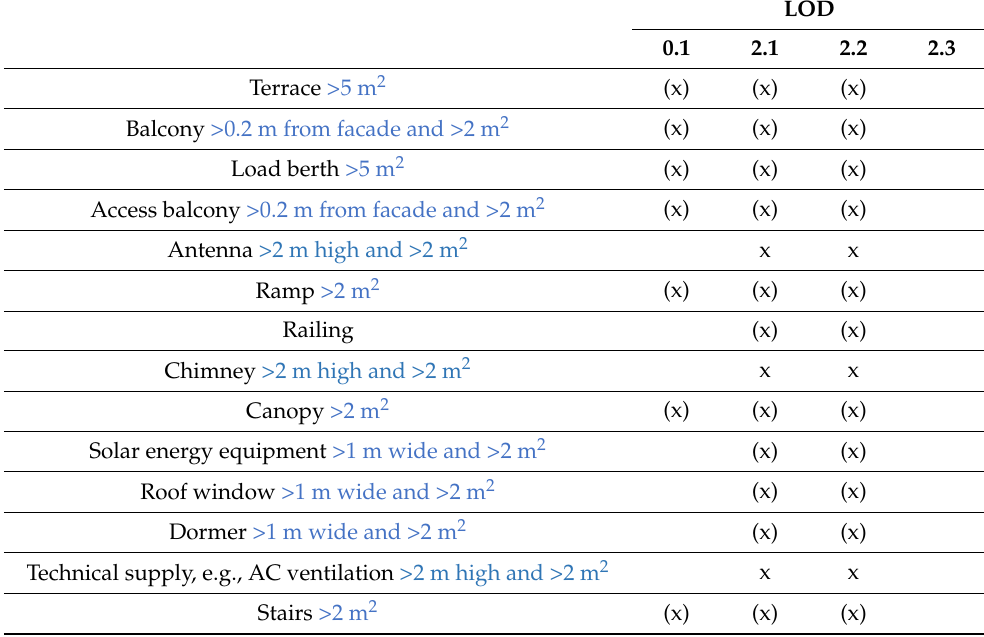
Table 1. Generalisation rules for building installations (airborne collection). x stands for compulsory data collection and (x) stands for data collection if needed . According to the specifications, the data should be collected with a positional accuracy on